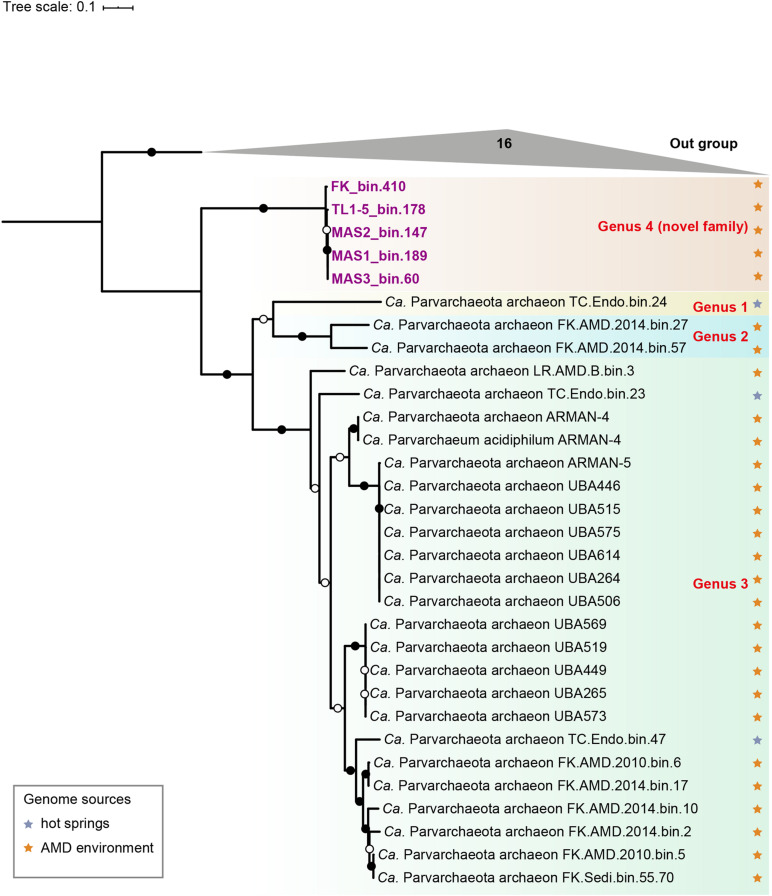
Phylogenetic tree of Parvarchaeota based on concatenation of 16 ribosomal proteins. Different clades are showed by boxes with diverse colors and MAGs newly obtained in this study are labeled with purple. Isolation sources of available Parvarchaeota MAGs are indicated by stars with different colors. Nodes with ultrafast bootstrap value ≥95% (50%) are indicated as solid (hollow) circles, and the scale bar at the bottom indicates 10% sequence divergence.